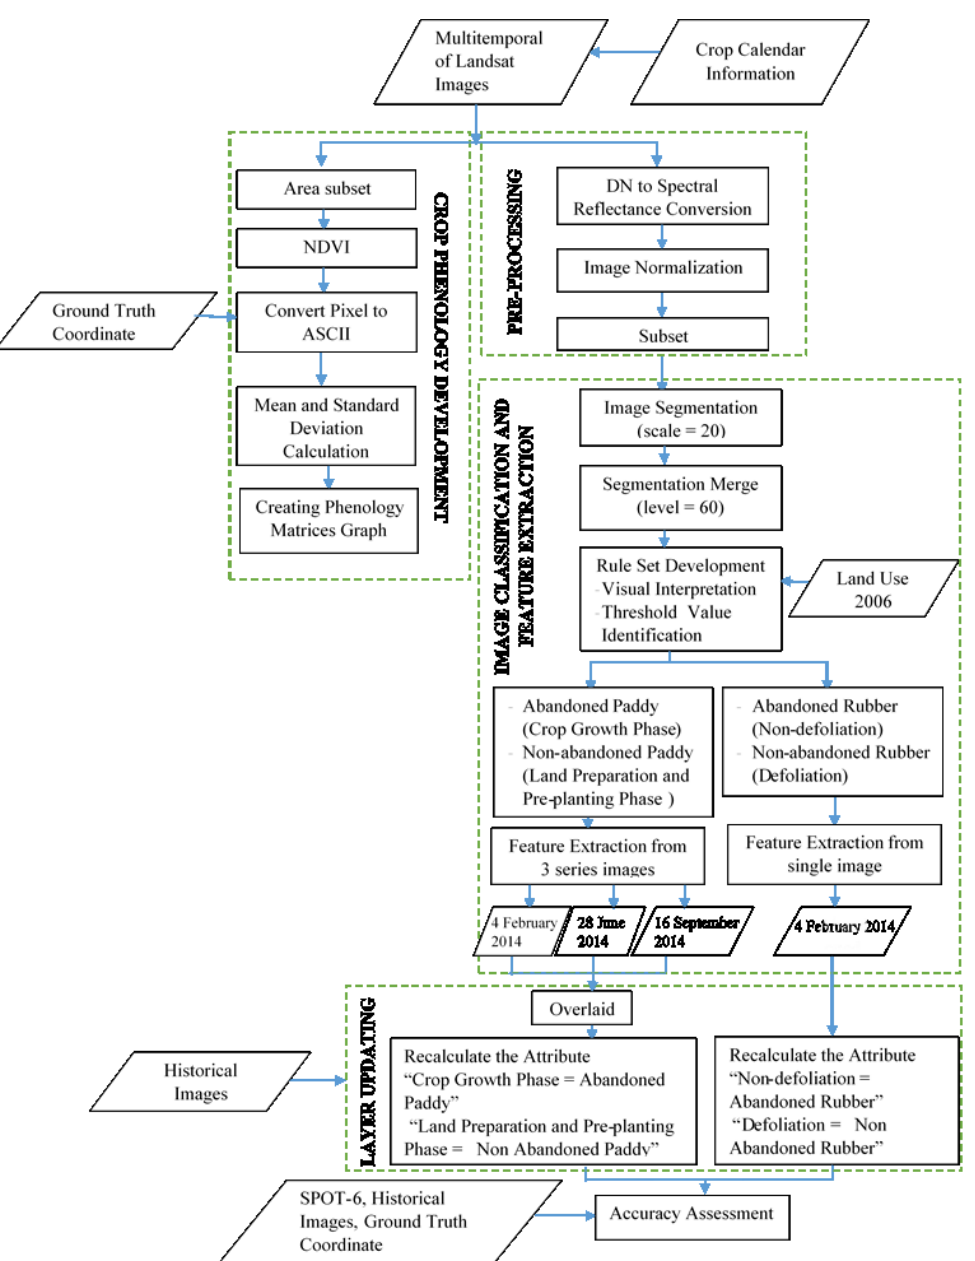
Figure 2. Workflow for abandoned and non-abandoned paddy and rubber feature